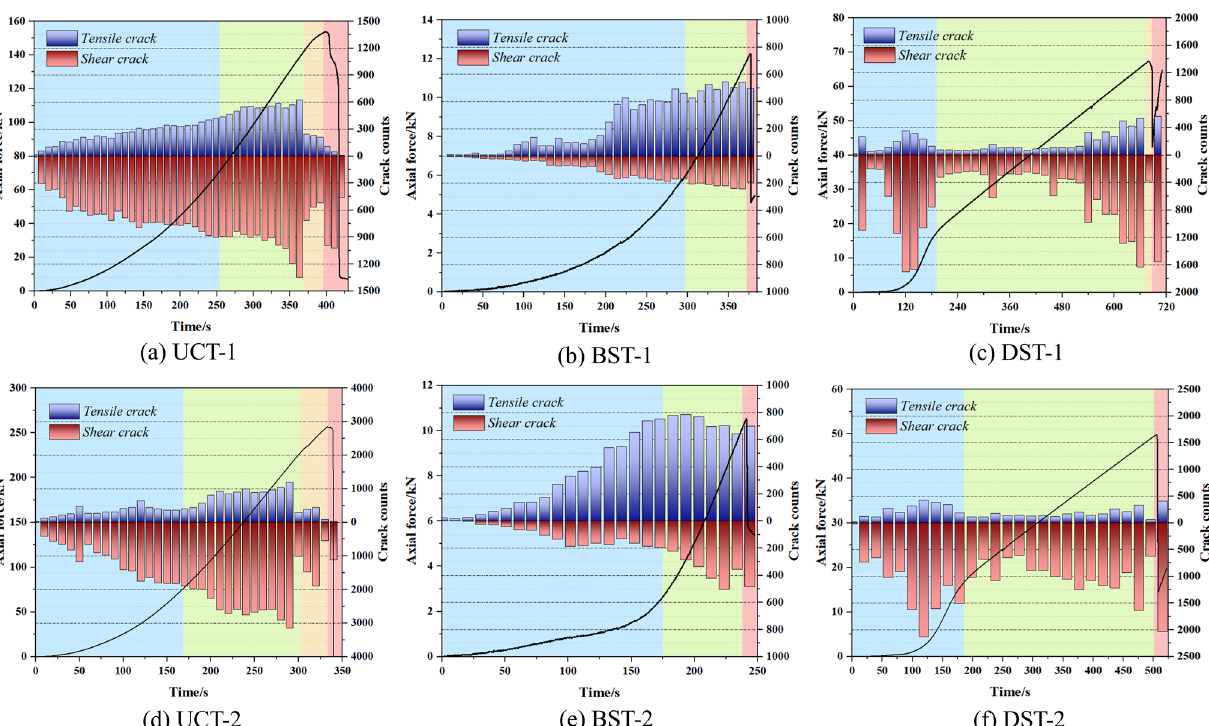
Fig. 6 Evolution of each type of crack: a UCT-1; b BST-1; c DST-1; d UCT-2; e BST-2; f